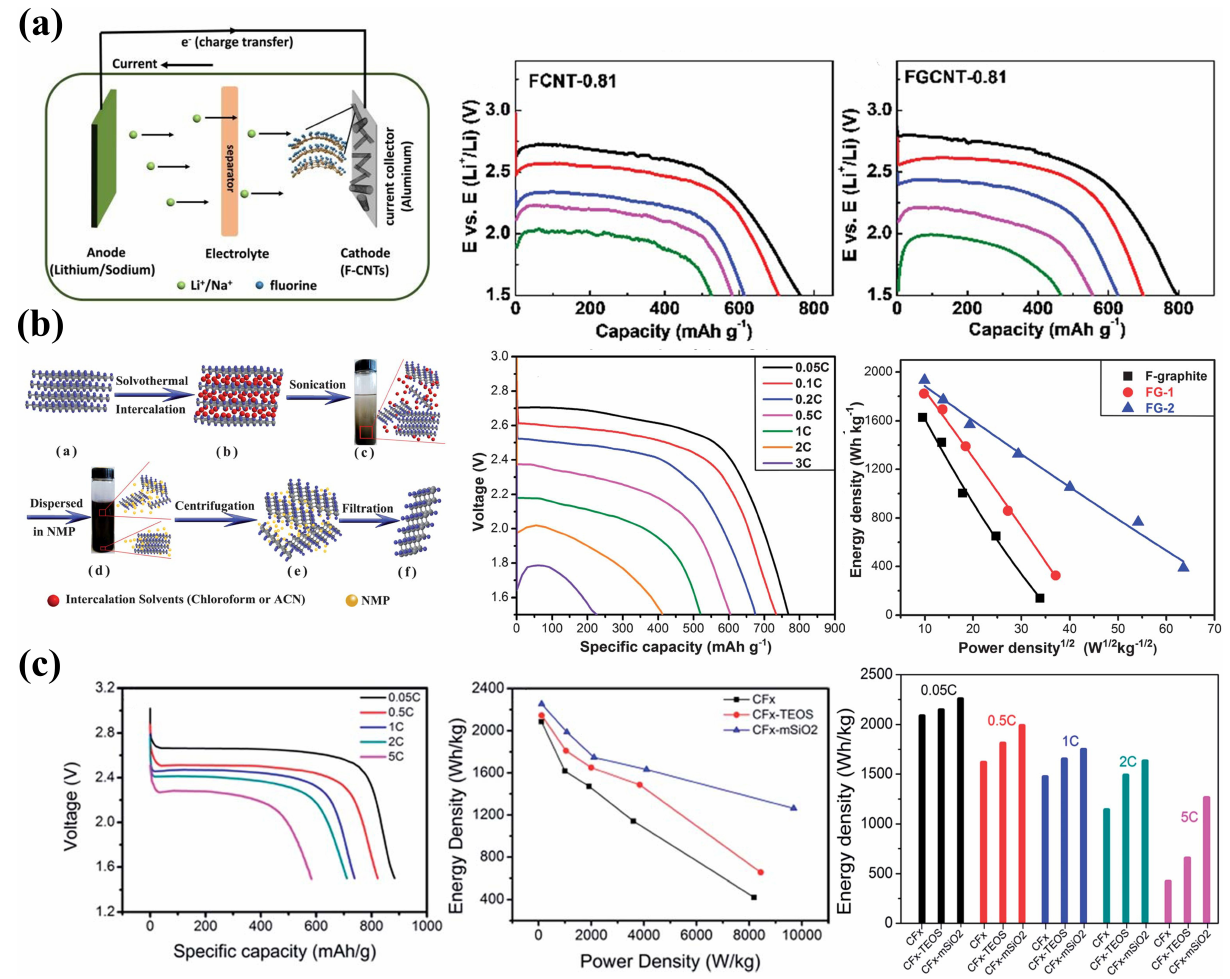
Figure 3: (a) Schematic of FCNT primary lithium/sodium battery, galvanostatic discharge curves of FCNT and FGCNT at different current density of 10, 100, 500, 1000, 2000 mA g −1 for primary lithium battery. Reprinted with permission from [53]. (b) Schematic illustration of the preparation of FG nanosheets by the intercalation and exfoliation, the galvanostatic discharge curves at different discharge rates and the Ragone plot of FG. Reprinted with permission from [91]. (c) The galvanostatic discharge curves, Ragone plot and gravimetric energy densities at different discharge rates. Reprinted with permission from